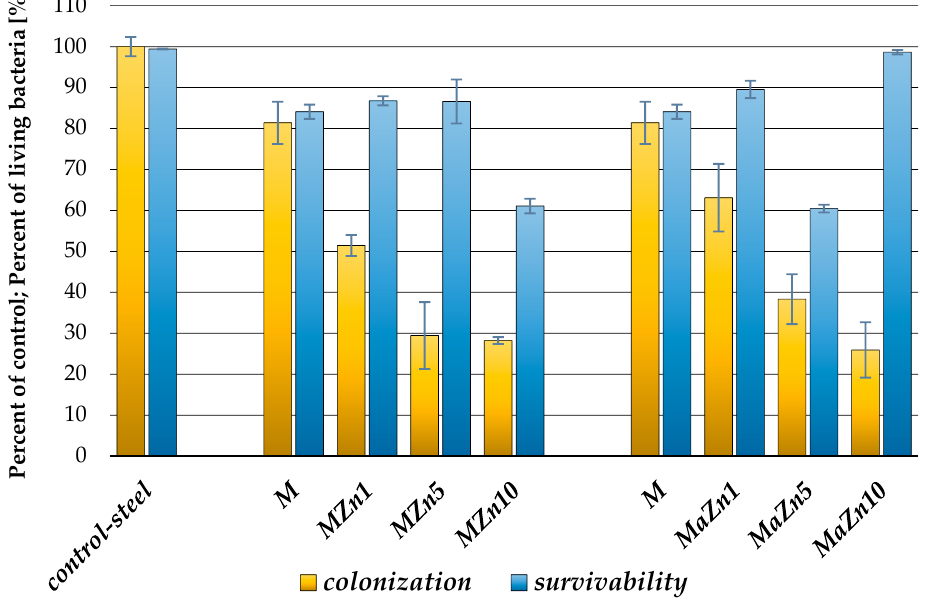
Figure 9. Comparison of antibacterial properties of M type coatings doped by different Zn compounds: nitrate (MZn1, MZn5, MZn10) and acetate (MaZn1, MaZn5, MaZn10).